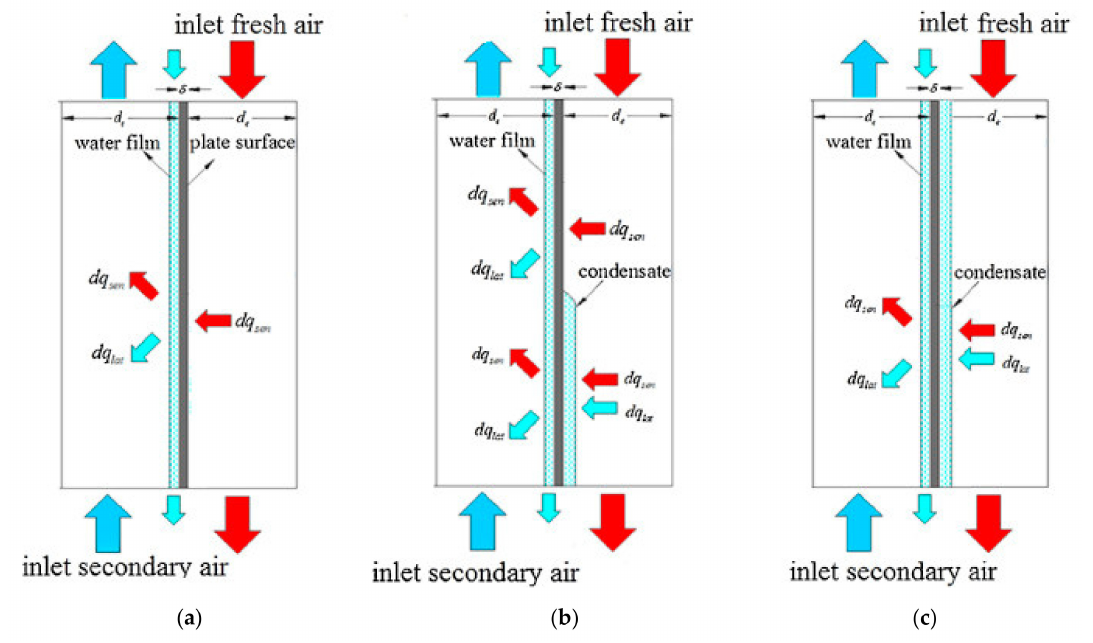
Figure 5. Schematic diagrams of IEC under different condensation states: ( a ) non-condensation, ( b ) partial condensation, and ( c ) condensation. Reprinted with permission from Ref. [48]. Copyright 2015, Elsevier.